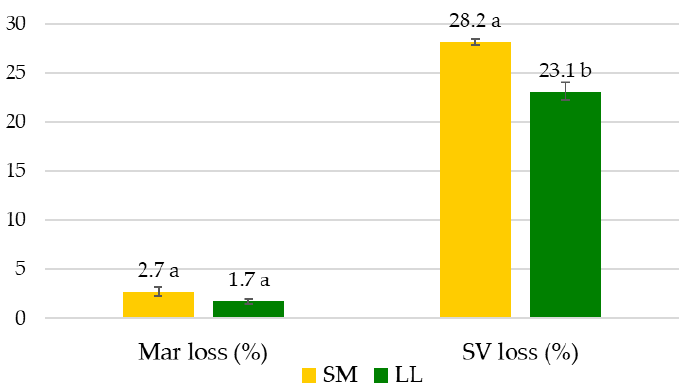
Figure 2. Marinating (Mar) and sous vide (SV) losses (%) in samples of semimembranosus and longissimus lumborum muscles subjected to marinating and sous vide (SVMar) treatment. Vertical bars indicate standard error of the mean, and a and b represent values with different letters differing at p < 0.001.